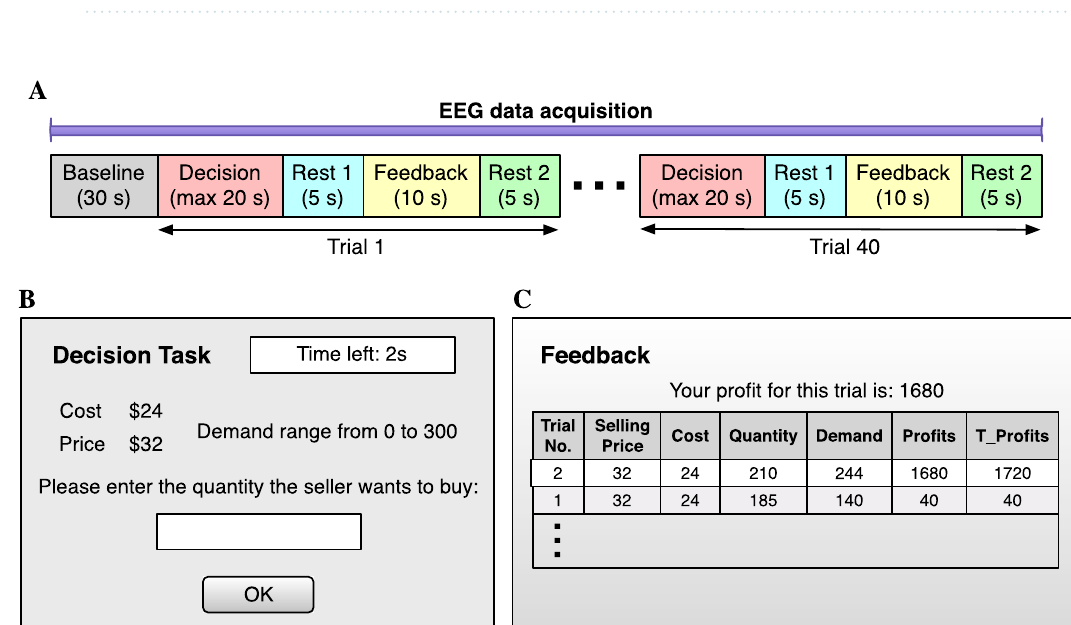
Figure 1. Flowchart outlining the hypotheses, procedural steps, and intended results for the study of 64-channel EEG data in response to the NP-based decision-making task.